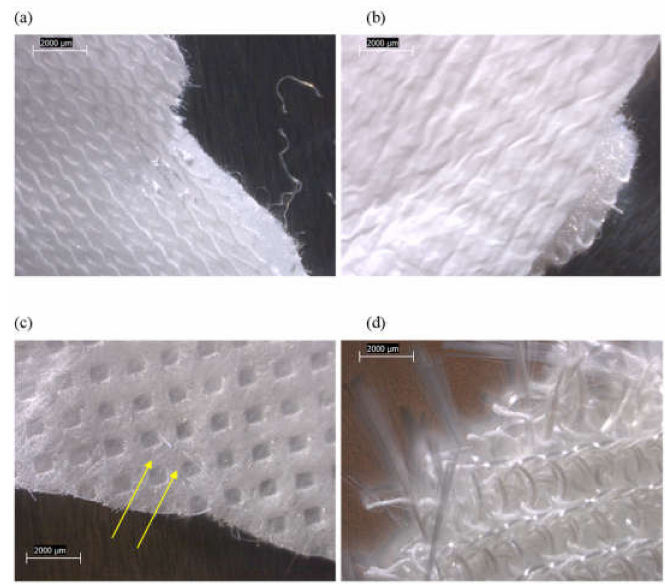
Figure 5. Low-power reflected-light stereozoom microscope images of FG-4 mattress subsamples acquired at 10 × . ( a ) White, synthetic, woven outer surface of outer cover material. ( b ) White, synthetic inner plastic sheet surface of outer cover material. ( c ) Inner cover material consisting of synthetic fibers in polymeric binder, and short straight fiberglass fibers sticking into surface (indicated by arrows). ( d ) Inner sock material, showing woven threads consisting alternately of white synthetic fibers and shiny/clear fiberglass